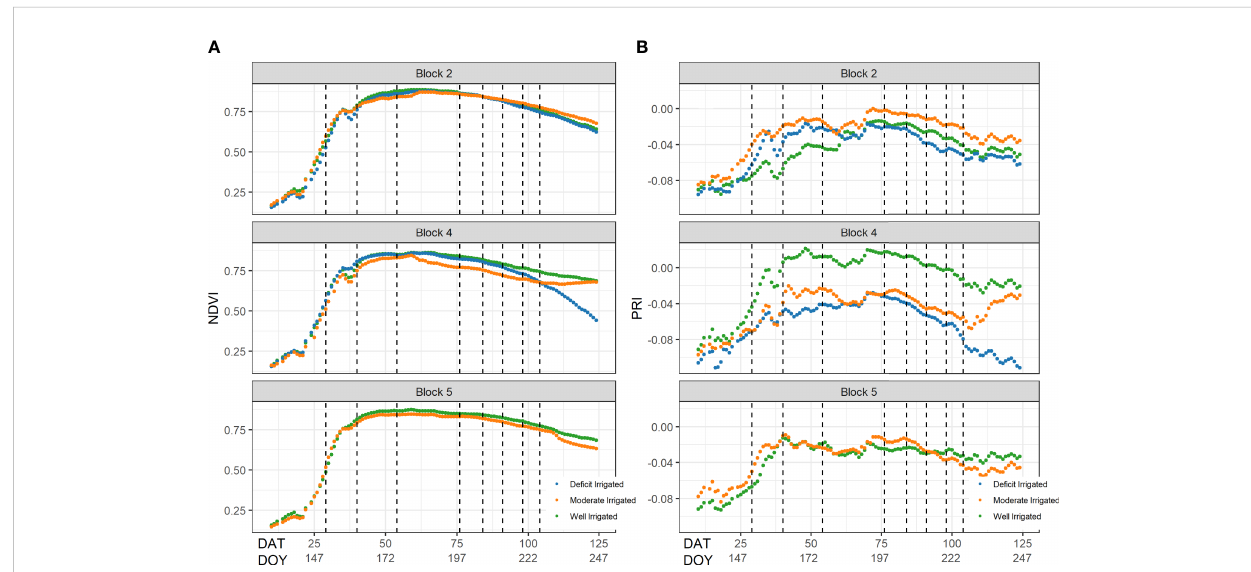
FIGURE 3 The seasonal changes of (A) normalized difference vegetation index (NDVI) and (B) photochemical re fl ectance index (PRI) from the proximal sensors across different plots. The x-axis represents the day after transplanting (DAT) and Julian day of year. The vertical lines represent the dates when the stem water potential was measured on the